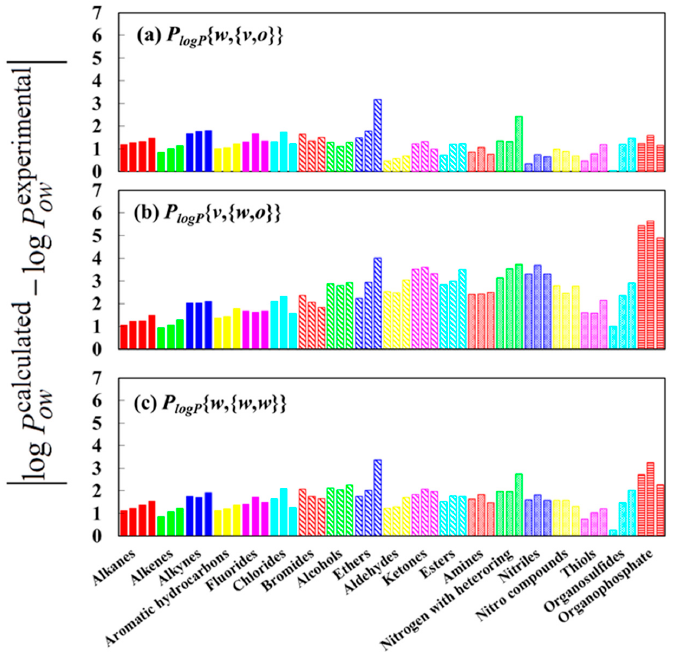
Figure 5. Error of log P ow with (a) P logP {w, {v, o}} , (b) P logP {v, {w, o}} , and (c) P logP {w, {w, w}} for the experimental values. Here, the left-to-right order of the compounds in each group is the same as the top-down order in Table S1. Table 4. Summary of log P ow calculations.